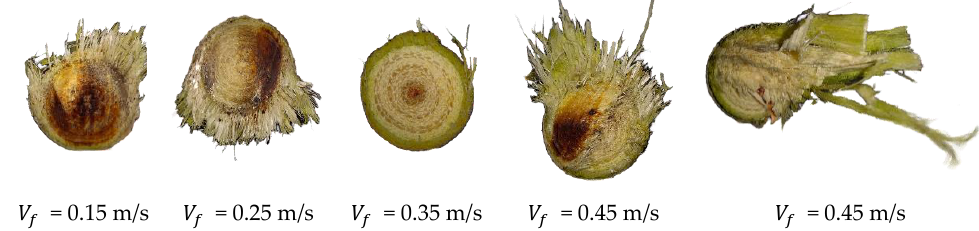
Figure 15. Cutting quality with different feed speeds.